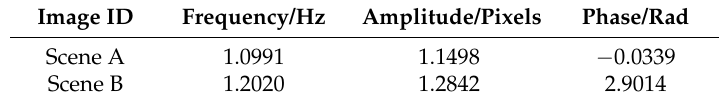
Table 10. Statistical accuracy results (unit: pixel) Table 9. Fitting results of absolute distortion across the track according to the ortho-images.